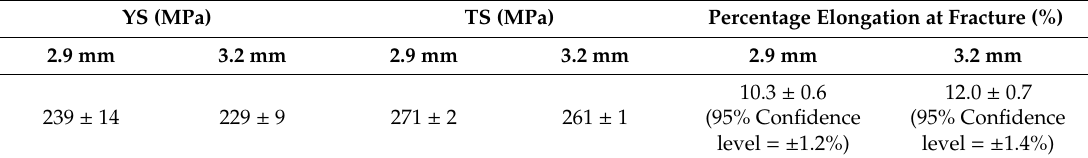
Table 2. Tensile tests results (mean and standard deviation of ten measurements).